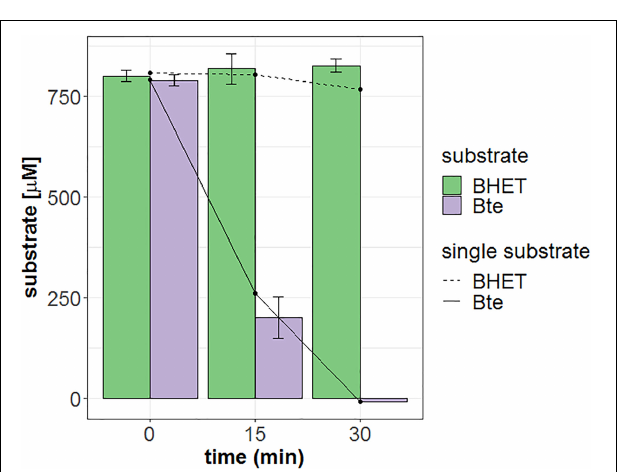
FIGURE 4 | Degradation of Bte, BHET, or a mixture of both by Mle046. Bte and BHET supplied as single substrates are shown as solid and dashed lines, respectively. The mixture of Bte and BHET is shown as purple and green filled bars, respectively. The sampling points are shown at 0, 15, and 30 min. Error bars indicate standard deviation ( n =